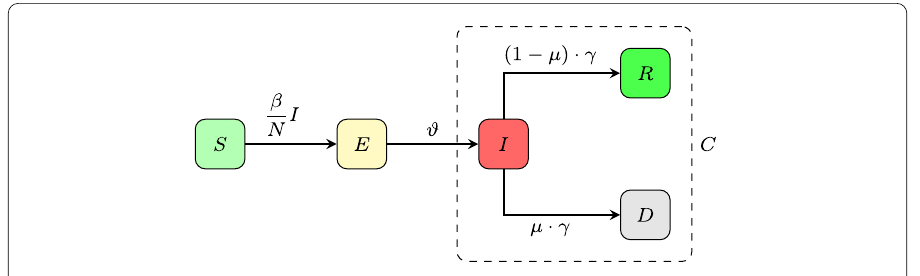
Figure 2 Transmission diagram for the basic SEIRD-model (1a)–(1e). The artificial compartment C contains all infected cases, i.e. current active infections, recovered and